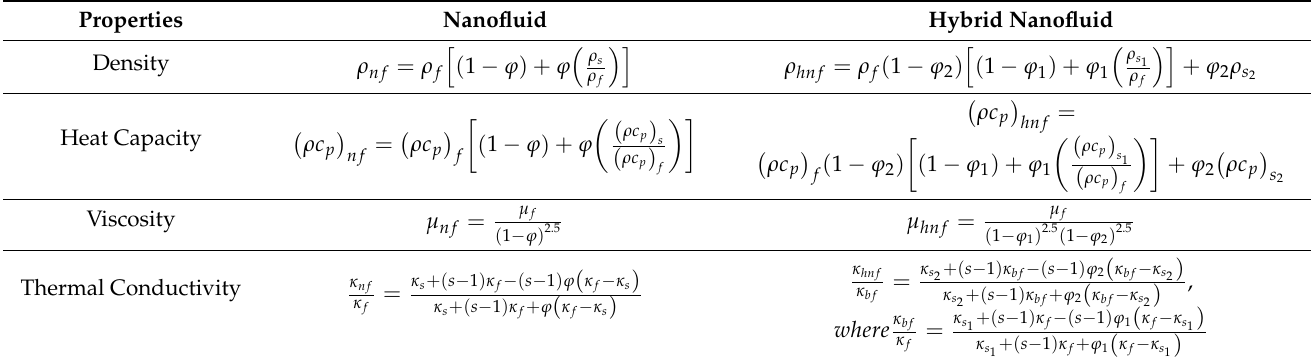
Table 2. Formulas for thermophysical properties of nanofluid and hybrid nanofluid [40]. Properties